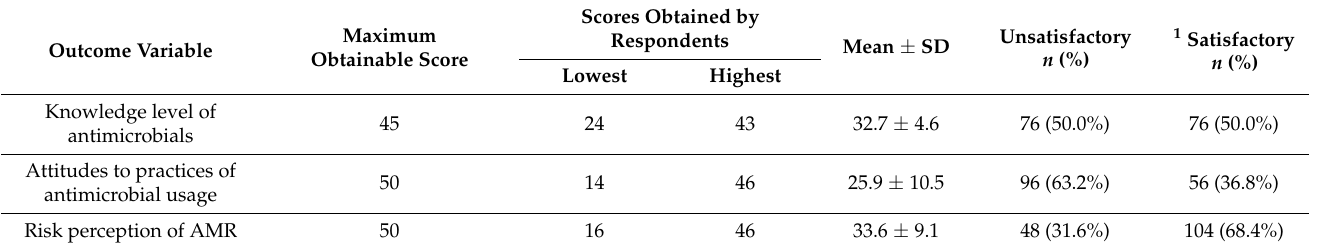
Table 1. Description of scores from outcome variables of respondents.